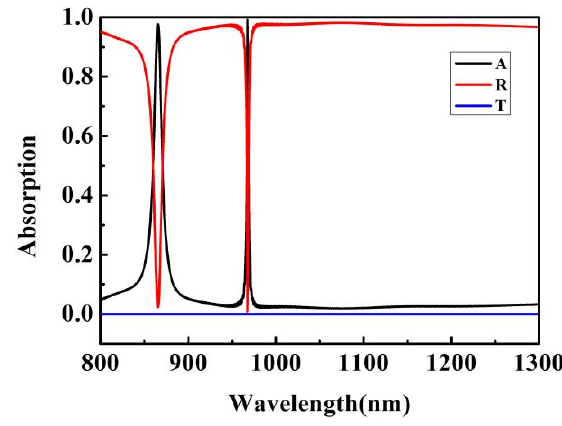
Figure 2. Spectra of R, T, and A under TM polarized light.